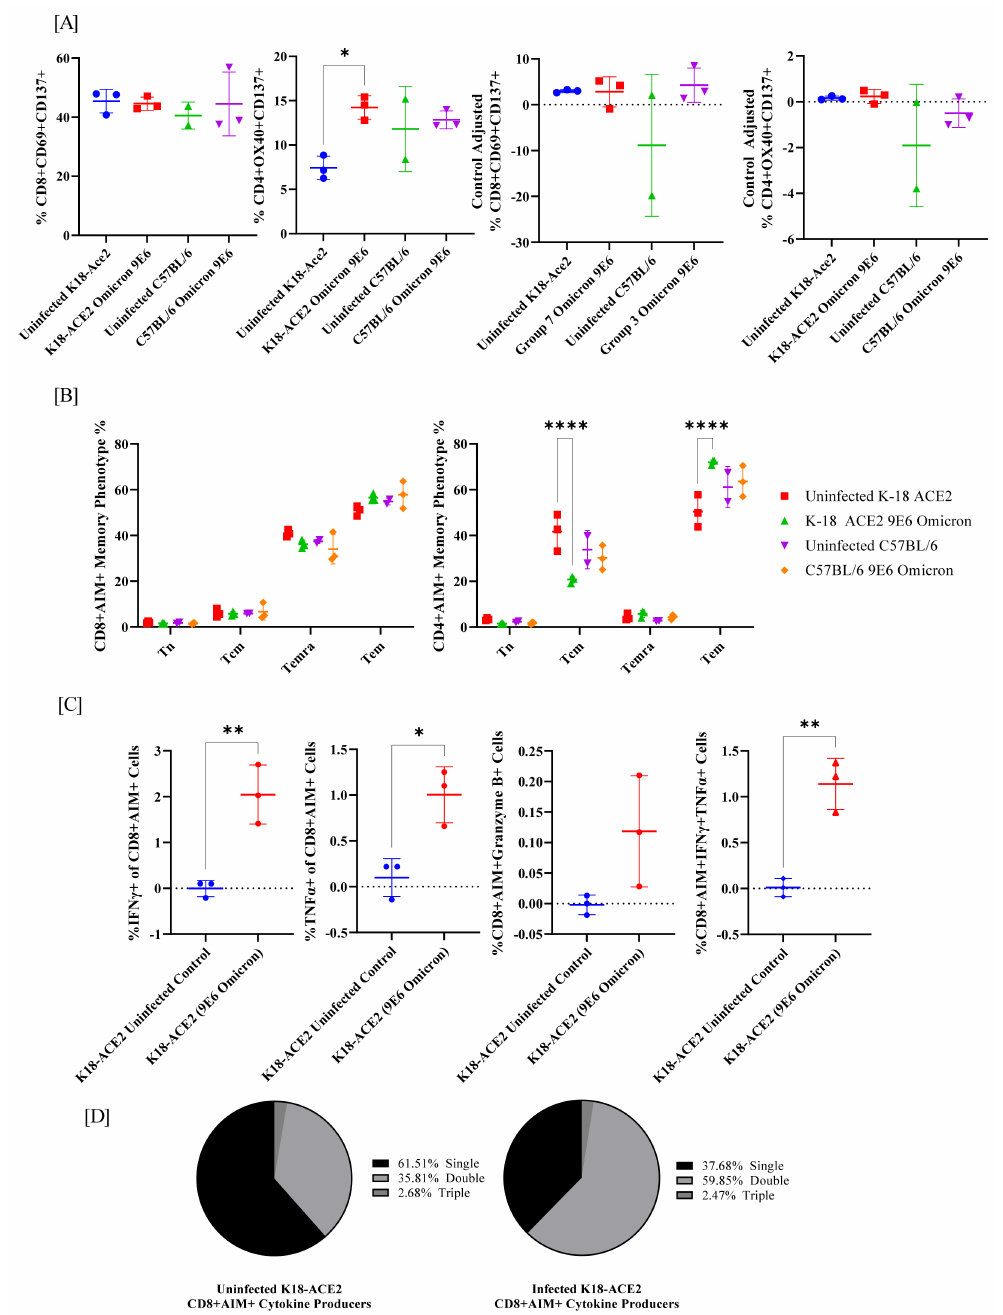
Figure 4. Omicron infection increases CD4+ AIM+ Tem population and promotes cytokine production in AIM+ CD8+ T cells in K18-hACE2 mice. ( A ) CD8 and CD4 AIM+ T cell populations in two mouse models after Omicron challenge. Graphs on the left are Omicron-peptide-stimulated samples unadjusted for control wells, graphs on the right have unstimulated control wells subtracted from Omicron-peptide-stimulated wells. ( B ) CD8+ AIM+ and CD4+ AIM+ memory phenotype was analyzed by gating naïve (Tn; CD45RA+ CCR7+), central memory (Tcm; CD45RA − CCR7+), effector memory (Tem; CD45RA − CCR7 − ), and terminally differentiated effector memory (Temra; CD45RA+ CCR7 − ) cells. ( C ) CD8+ AIM+ T cells producing IFN-gamma, TNF-alpha, or Granzyme B by intracellular cytokine staining. ( D ) Multifunctional activity profiles of CD8+ AIM+ T cells evaluated from IFN-gamma, TNF-alpha, and Granzyme B. Asterisks represent statistical significance by ANOVA test where (*) p ≤ 0.05; (**) p ≤ 0.01; (****) p ≤ 0.0001; if (ns) p > 0.05 not